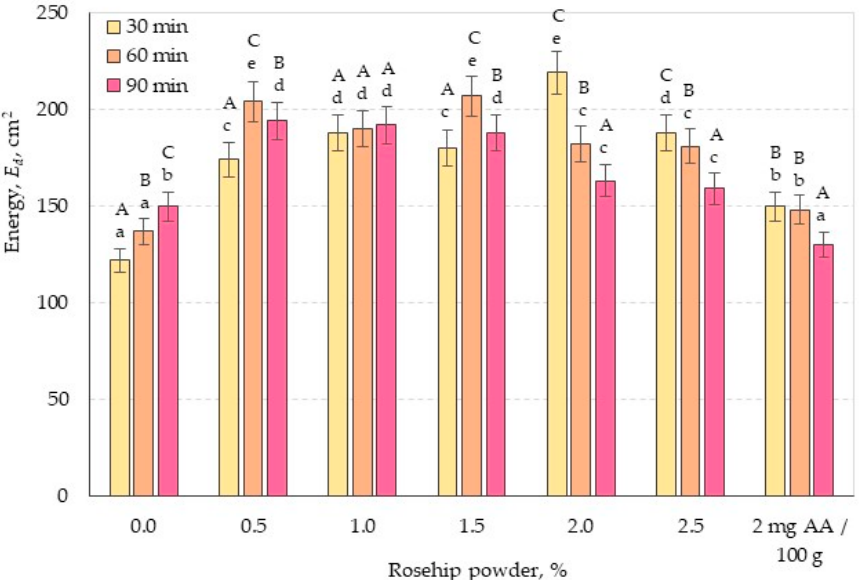
Figure 4. Dough energy ( E d , cm 2 ) as a function of Rp addition. Different capital letters represent statistically different mean values ( p ≤ 0.01) of each sample for different times (30, 60, and 90 min). Different lower-case letters are responses statistically different ( p ≤ 0.01) of all samples for each time (30, 60, and 90 min). AA is ascorbic acid.